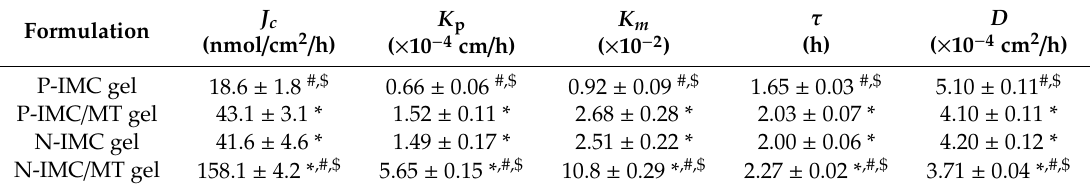
Table 1. Pharmacokinetic analysis of IMC transdermal formulations in in vitro skin penetration. Formulation